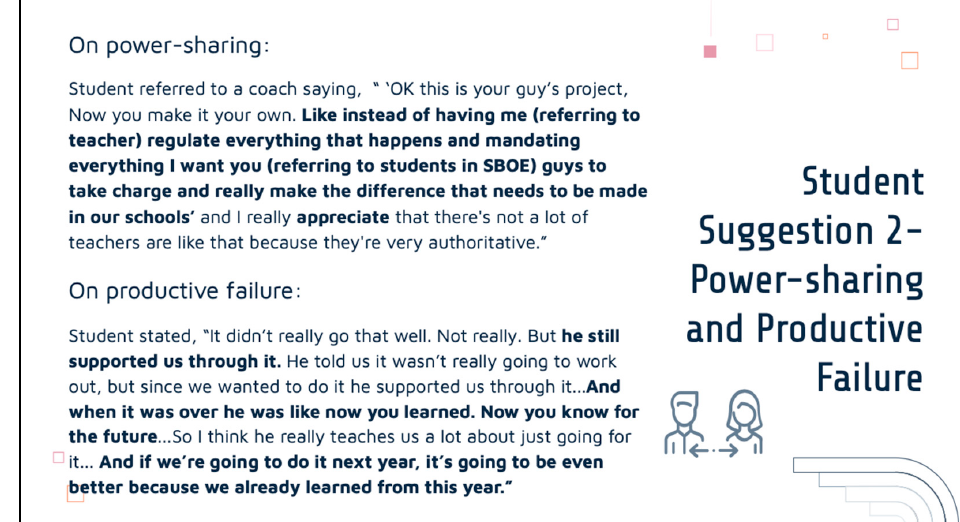
Figure 1. Google slide with the claim about productive failure.